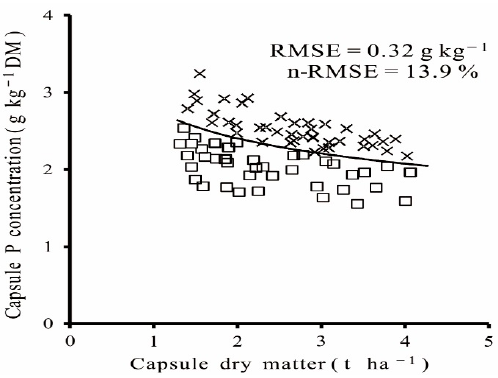
Figure 6. Validation of the critical phosphorus (Pc) curve using the independent data set from Experiments 1 and 2. Data points ( □ ) and (×) represent P-limiting and non-P-limiting treatments, respectively. The solid line depicts the Pc curve based on the capsule dry matter of flax.